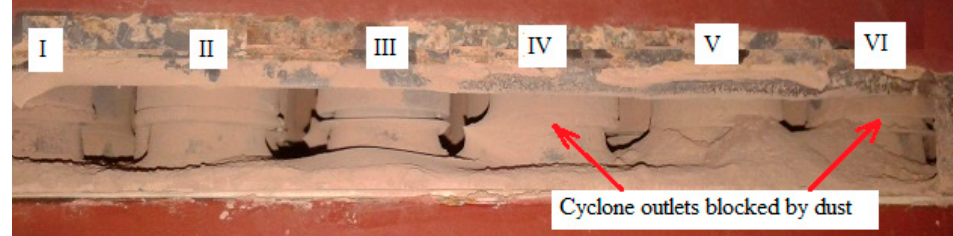
Figure 17. The cyclone outlets of the multi-cyclone after a supply of 2150 g of dust into the